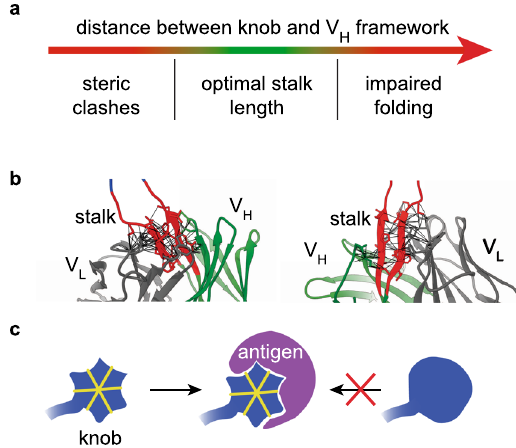
Fig. 5 Principles learned from bovine antibodies with ultra-long CDRs. a . An optimal stalk length in the ultra-long CDR-H3 ensures proper folding without steric clashes between the knob and residues in the variable domains. b There is a consensus between the stalk of CDR-H3 with some of the other CDRs. Depicted are part of the variable domains of NC-Cow1 (PDB:6OO0). The bovine stalk in CDR-H3 is in red, the remaining of the V H domain is in green, the V L domain is in gray. The black lines illustrate a network of potential contacts between the residues in the stalk and some of the other CDRs. c The disul fi de bonds (yellow lines) in the ultra-long CDR- H3 (blue) provide conformational restraints crucial for binding to the antigen